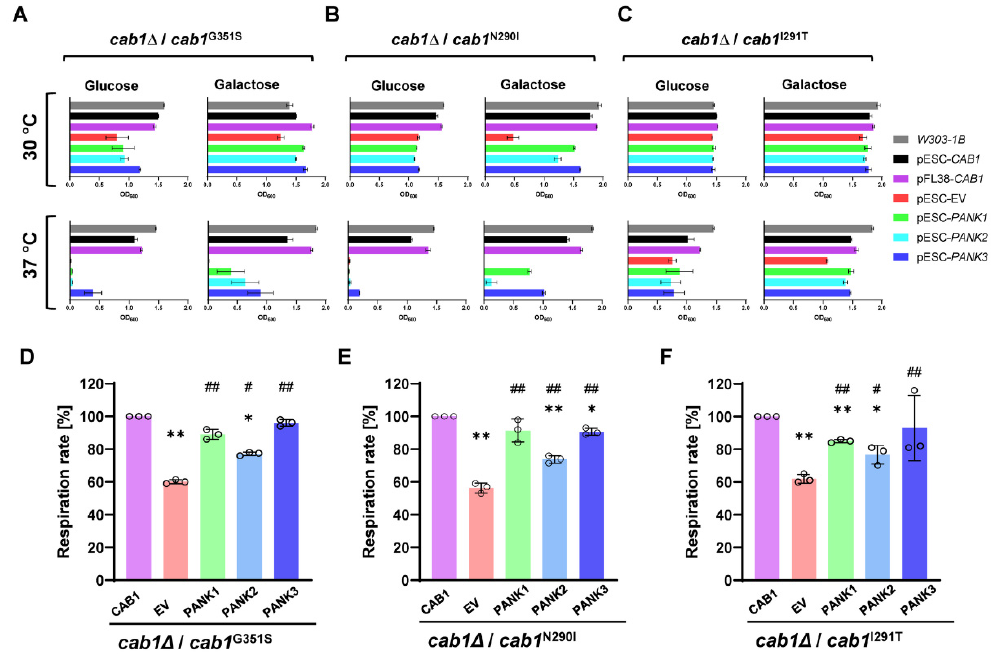
Figure 3. Cellular activity and respiration rate of mutant strains expressing human PANKs. ( A – C ). Representation of the mid-log phase growth of yeast strains cab1 Δ /cab1 G351S ( A ), cab1 Δ / cab1 N290I ( B ), and cab1 Δ / cab1 I291T ( C ) carrying EV, CAB1 and human PANK s from data shown in Figure 2. The bar graphs show the OD 600 values of the strains expressing PANK s at the time point when the strains expressing the CAB 1 wild-type allele were at the late log phase (36 h for glucose and 60 h for galactose conditions, respectively). ( D–F ) Oxygen consumption rate was measured in the same strains grown at 28 °C or 37 °C (especially for the strain expressing the cab1 I291T mutant allele) in SC medium without uracil and tryptophan and containing 2% galactose. OCR was normalized to the corresponding mutant strain transformed with the CAB1 wild-type allele. OCR was conducted in triplicates ( n = 3) and the plotted graphs represent the average ± SEM. *: p < 0.05 and **: p < 0.01 relative to mutant strain transformed with CAB1 allele and #: p < 0.05 and ##: p < 0.01 relative to mutant strain transformed with the empty vector. Using ANOVA followed by Bonferroni’s post hoc test.